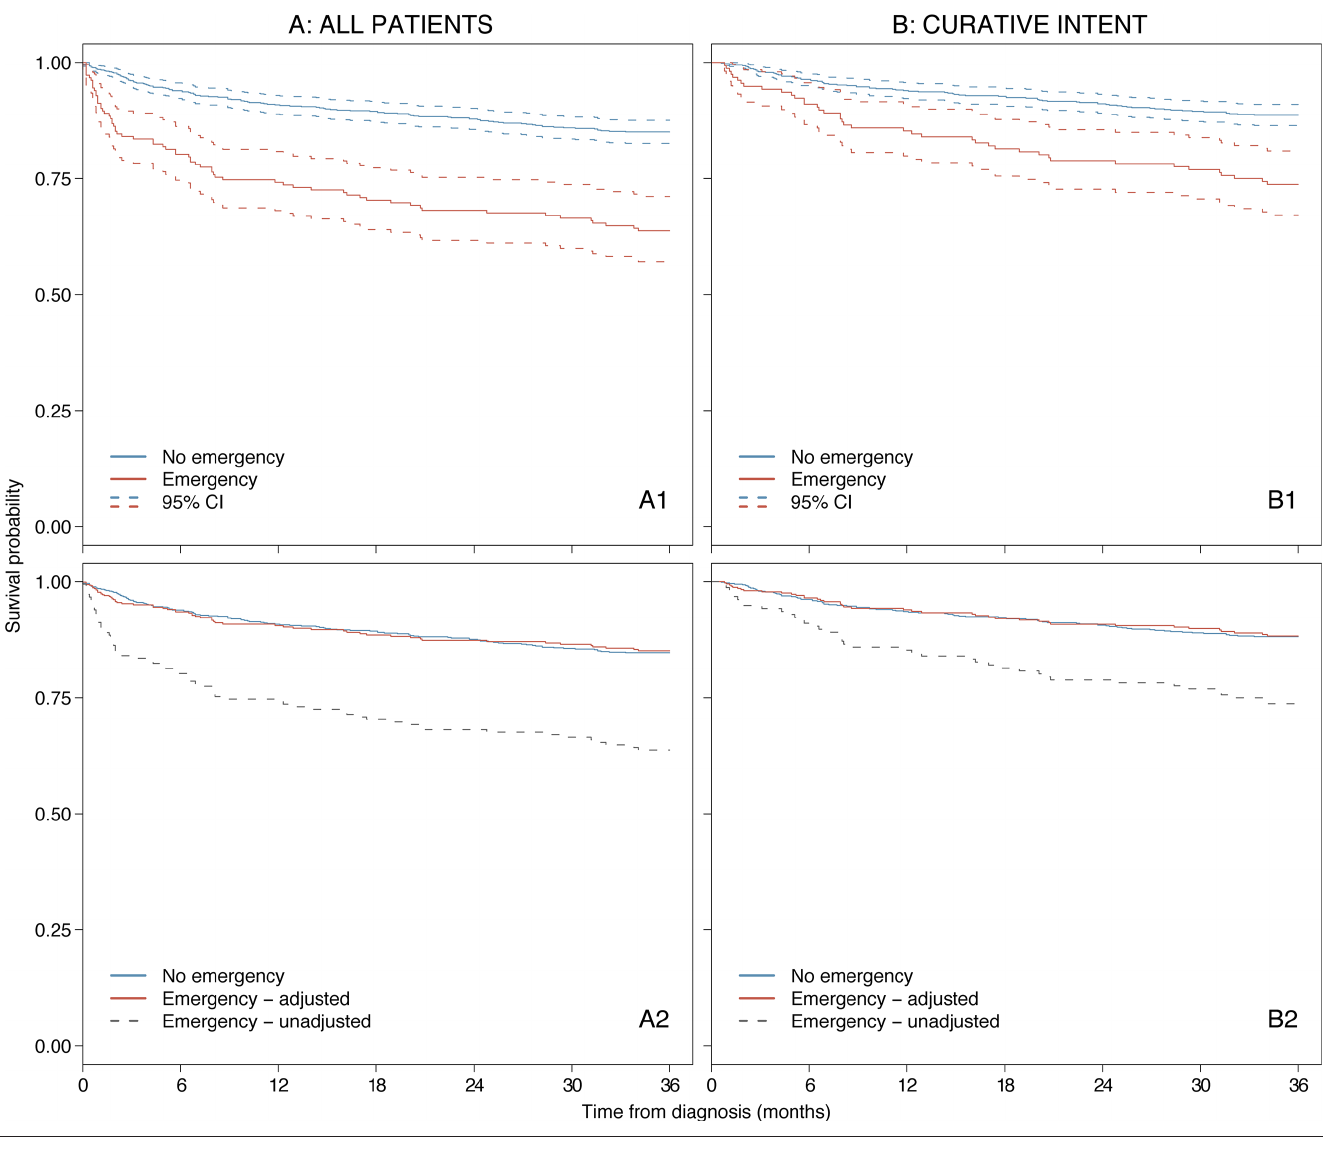
Figure 3 Classical Hodgkin lymphoma survival curves for all patients (A) and those treated with curative intent (B). Overall survival in non- emergency versus emergency admission with 95% CIs (A1, B1) and non- emergency versus emergency adjusted for prognostic factors (A2, B2). a (data from